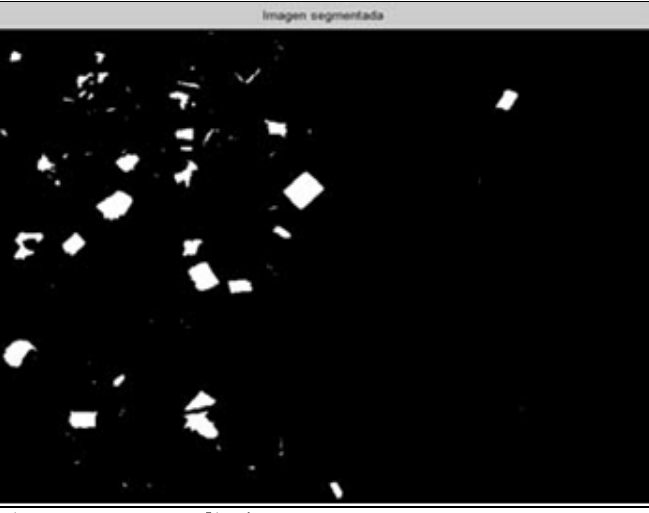
Figura 13: Imagen Alisada. Fuente: Los autores, (2018).